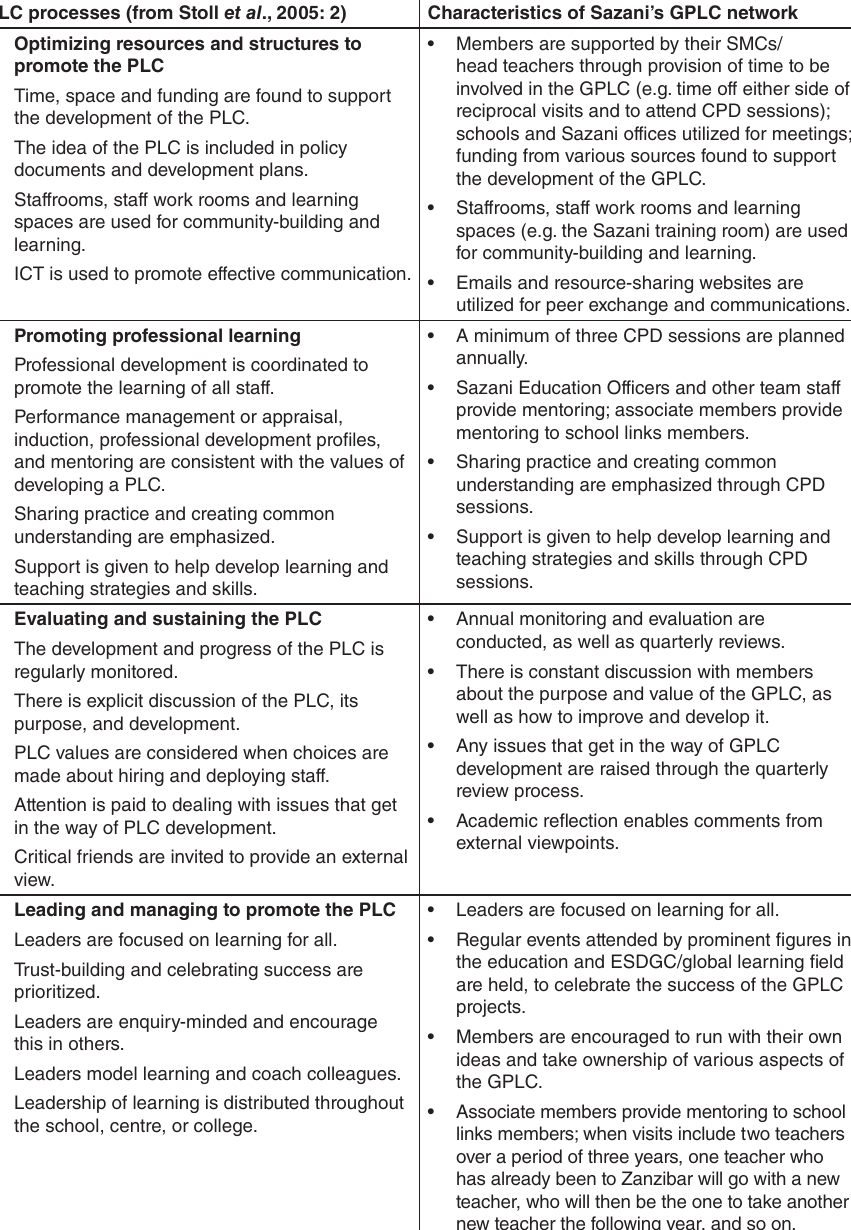
Table 1: Processes for developing a PLC – assessment of how Sazani’s network fits with the PLC